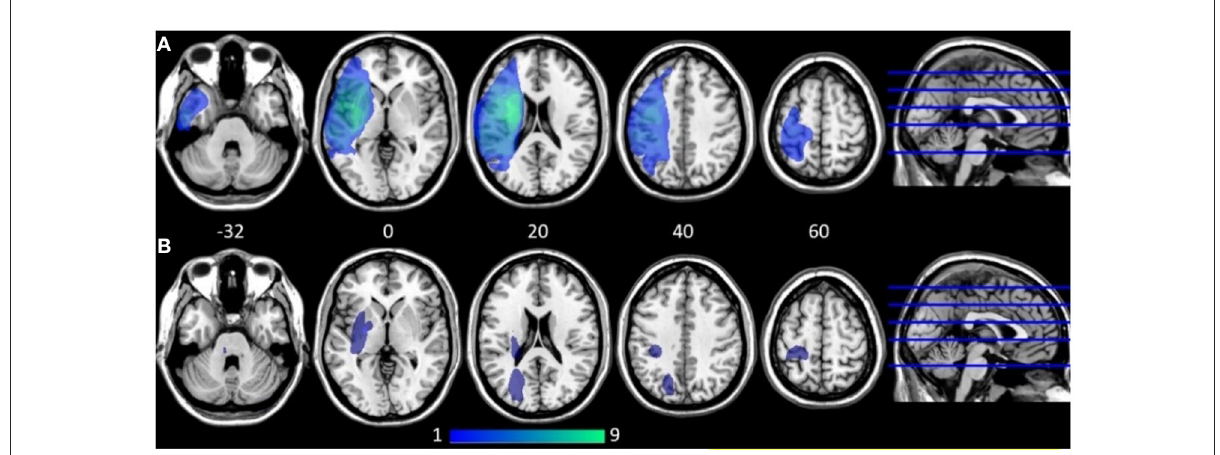
FIGURE1 Lesion overlap map at ≈ 4 weeks post stroke onset shown on five axial slices (z coordinates provided). Dark blue indicates low lesion overlap, light green indicates high overlap. (A) Participants with apraxia of speech, aphasia, and non-verbal oral apraxia ( n = 9). (B) Participants with no speech-language impairment ( n = 6). All participants with apraxia of speech, aphasia, and non-verbal oral apraxia had cortical lesions in the middle cerebral artery territory with extensions into deep subcortical white matter where the largest lesion overlap was found. SMA was not lesioned in any of the participants in the AOS group. The participants without speech-language impairment had in general smaller lesions spread in mainly subcortical areas.